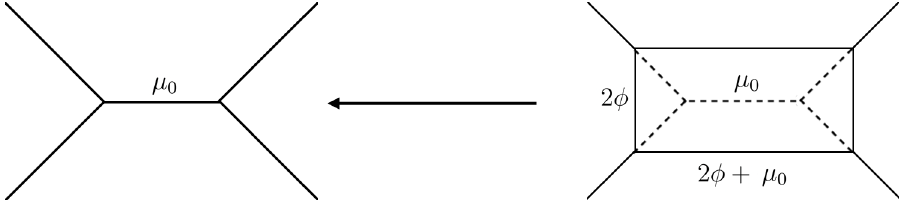
Figure 2 . F0 theory with positive bare coupling-squared ( µ 0 > 0